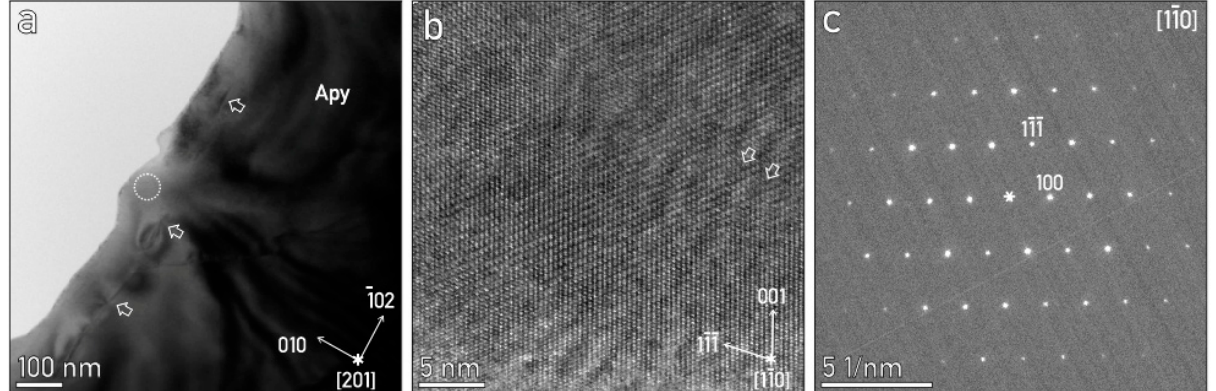
Figure 3. ( a ) Overview TEM micrograph of arsenopyrite (Apy) single crystal; arrows mark planar defects parallel to (010) plane; circle marks the SAED position. ( b ) HR-TEM of the bulk arsenopyrite sample viewed in [1–10], with marked main directions. White arrows mark a pair of moiré fringes. ( c ) SAED pattern recorded over ( b ) area, indexed for arsenopyrite structure from [9].